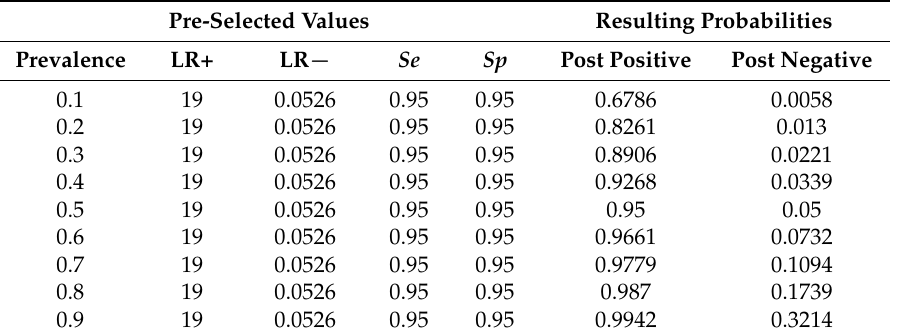
Table 2. The influence of prevalence on post-test probabilities when Se and Sp are kept equal. Pre-Selected Values Resulting Probabilities